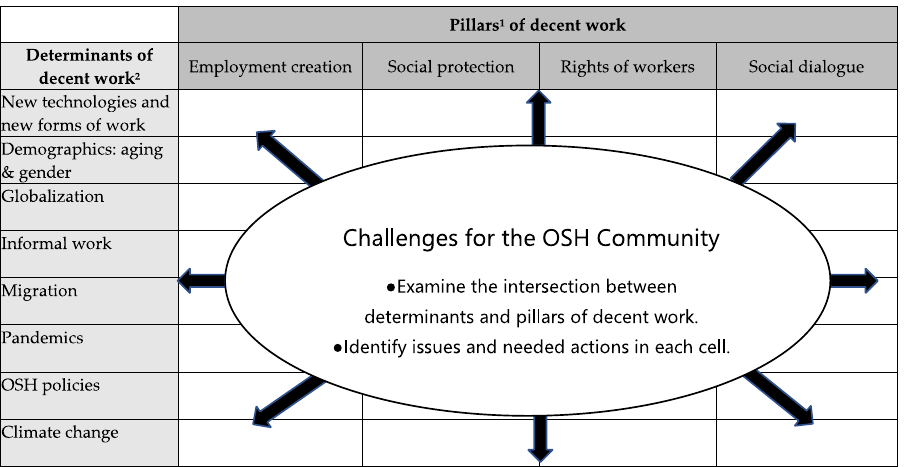
Figure 1. Occupational Safety and Health Staging Framework for Decent Work. 1 Pillars are strategic objectives of the ILO to promote decent work [3]. 2 Determinants are factors that positively or negatively influence the realization of decent work.